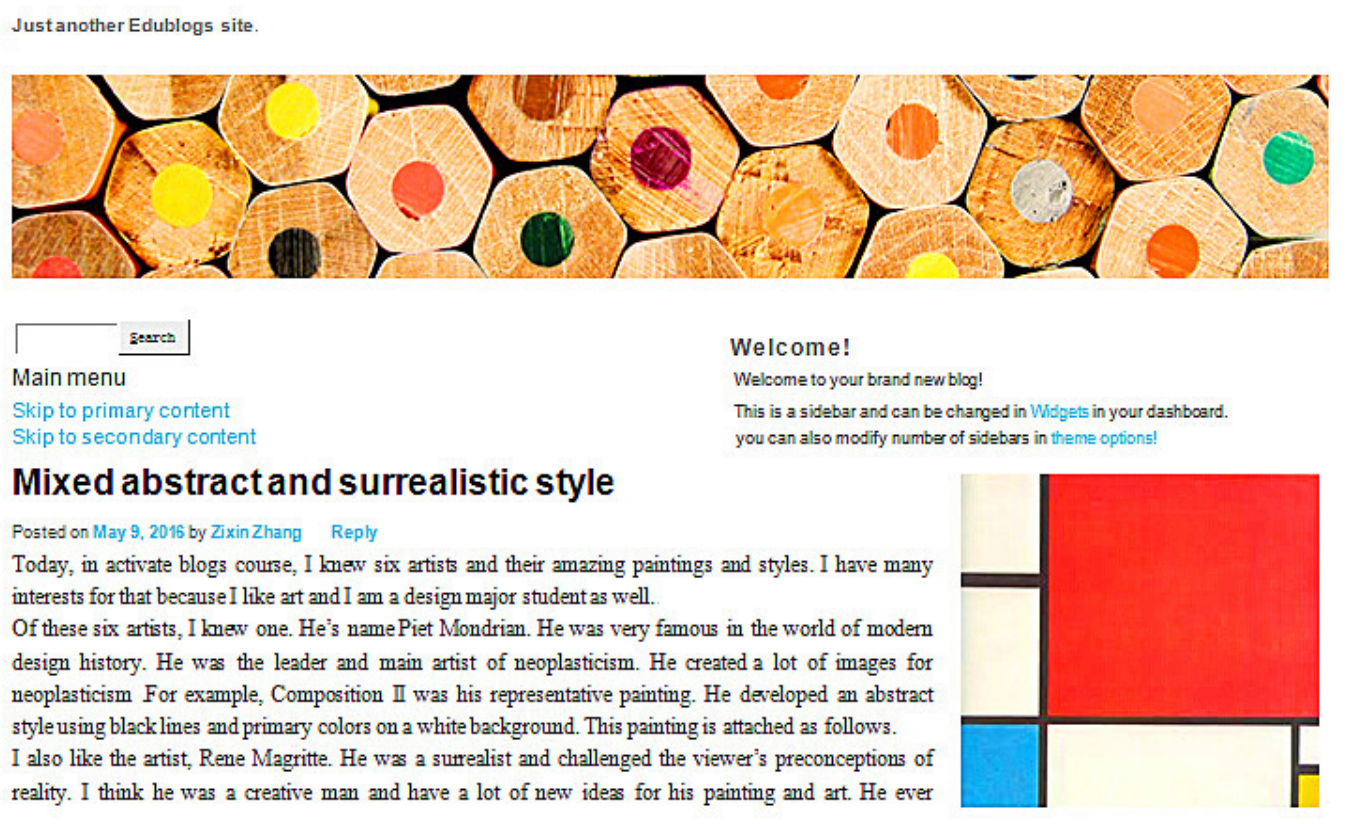
Figure 4. Blog interface (Bilingual Teaching) released by Modern Design History